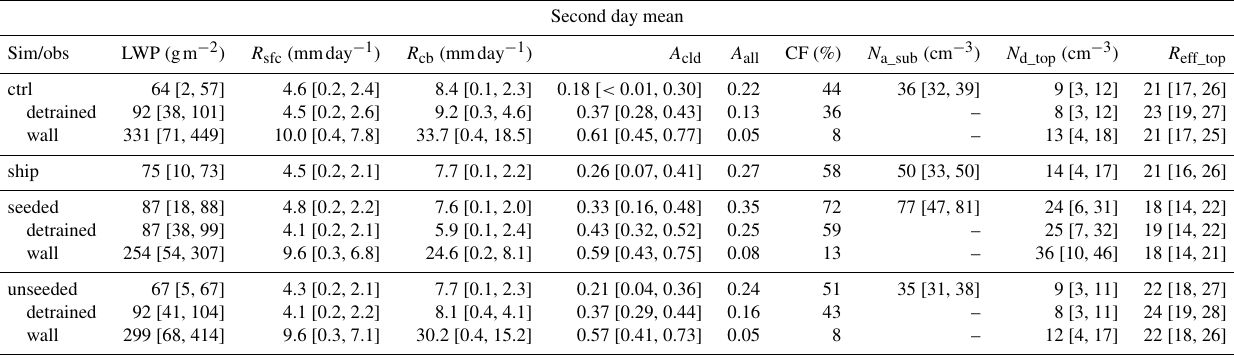
Table 2. Same as Table 1 but for mean values of the last 24h period. The following additional variables were added to the table: cloud albedo ( A cld ), all-sky albedo A all = CF · A cld + ( 1 − CF ) · A clr and cloud-top effective cloud droplet radius ( R eff_top ). A clr denotes the clear-sky albedo, which was determined as A clr = 0 . 06 in both simulations. R eff_top was diagnosed similarly to N d_top and averaged over cloudy regions only. For A all and A cld domain averages (i.e. including clear-sky and cloudy sky) are given. All entries for “wall” (cloud with updraft > 0 . 5ms − 1 ) and detrained (non-wall cloud) regions, denote in-cloud averages only. CF for wall and detrained cloud denotes the domain area fraction covered by each category. Inside cell walls and cloud filaments CF is 100%. The seeded region is defined as ± 30km around the emission line and the remainder of the domain is classified as